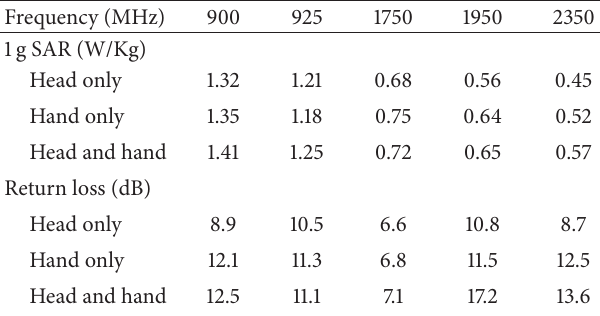
Table 1: Simulated SAR values for 1g